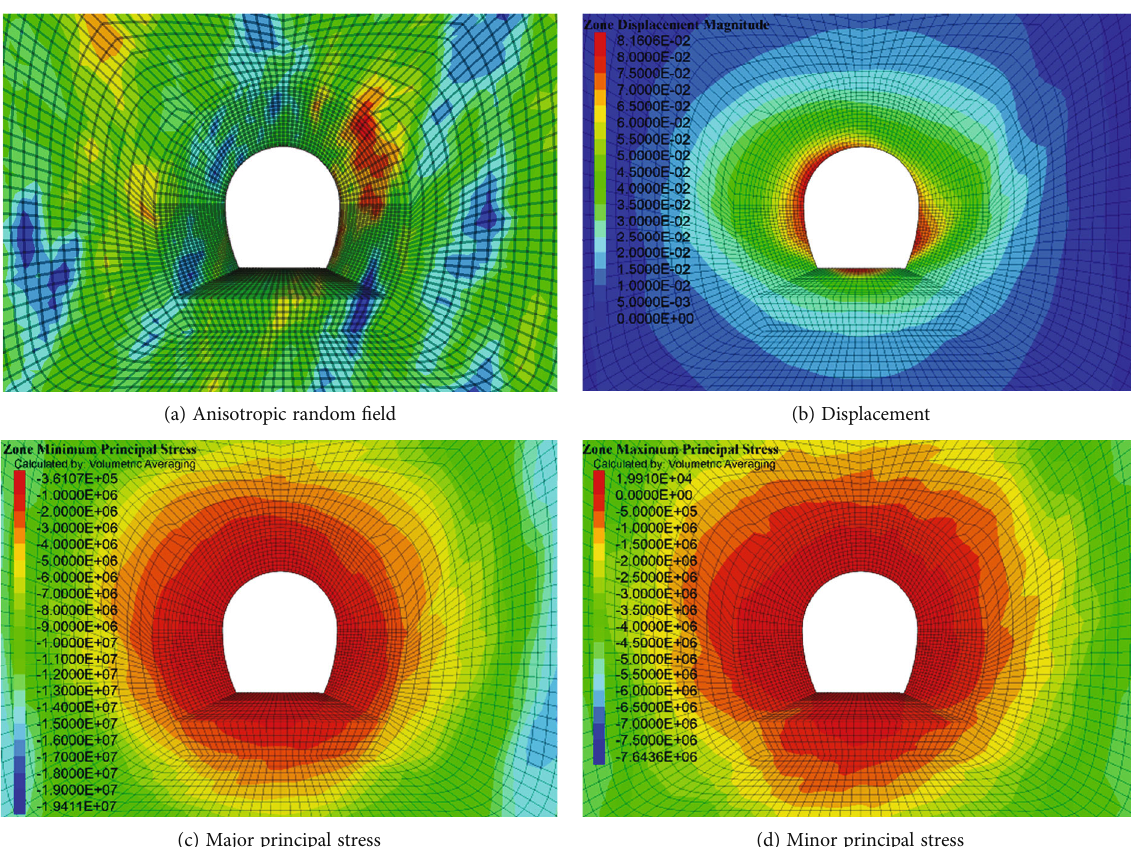
Figure 14: Analysis of cavern excavation results with 75 ° anisotropic fi